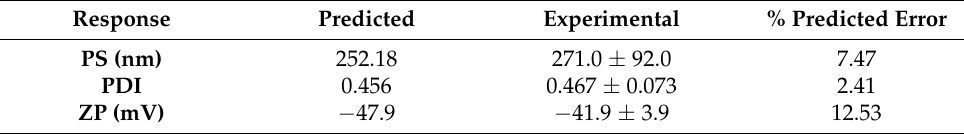
Table 7. Summary of results for the NCC using optimum formulation and process parameters.